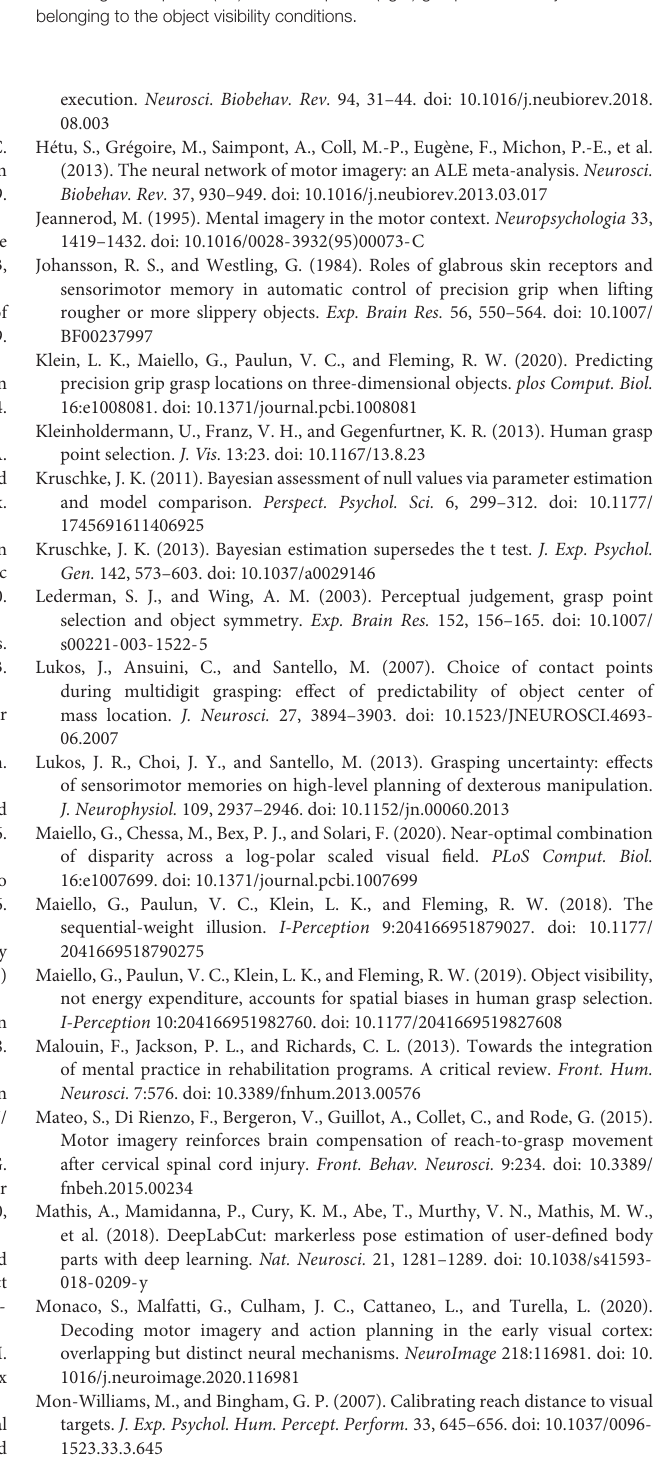
Supplementary Video 1 | Representative participant from Experiment 2a executing near-optimal (left) and sub-optimal (right) grasps for one object belonging to the natural grasp axis conditions. Supplementary Video 2 | Representative participant from Experiment 2a executing near-optimal (left) and sub-optimal (right) grasps for one object belonging to the object visibility